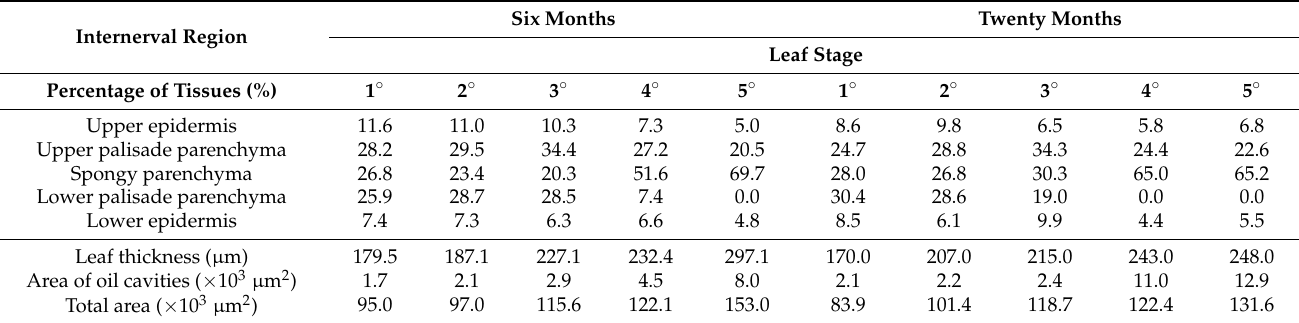
Table 3. Percentage of tissues in the upper epidermis, upper palisade parenchyma, spongy parenchyma, lower palisade parenchyma, lower epidermis, leaf thickness, area of oil cavities and total area in internerval region for the five growth stages of Eucalyptus grandis leaf development stages of 6- and 20-month-old